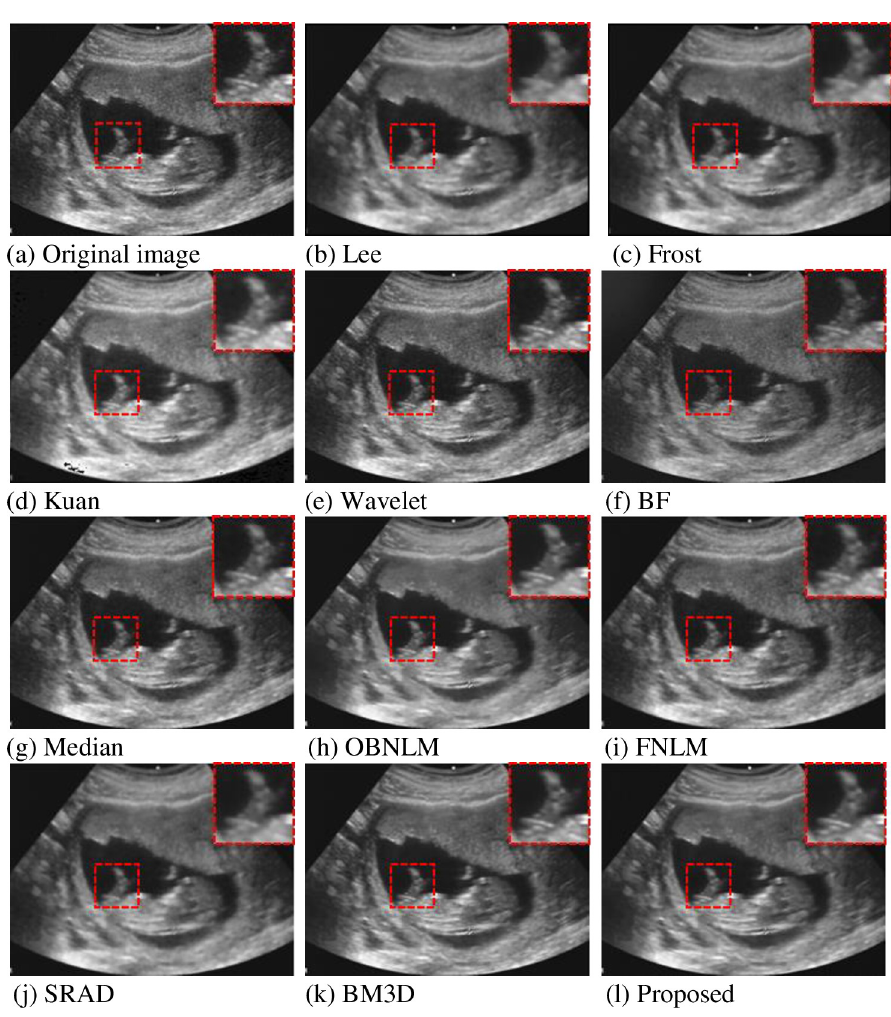
Fig 9. Effect of fetal ultrasound